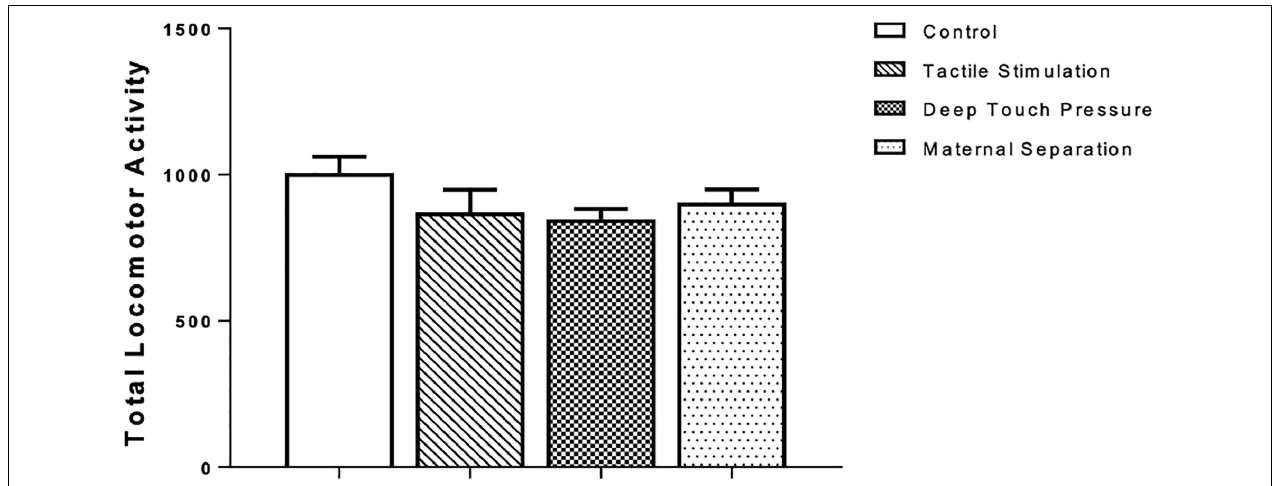
FIGURE 3 | Locomotor activity in WAG/Rij rats submitted to TS, DTP, and MS in comparison to unhandled control group. The data are presented as mean ± SEM ( n = 10 per group). Total locomotor activity, photocell count in 10 min ( P > 0.05). There was no statistically significant difference among groups according to one-way